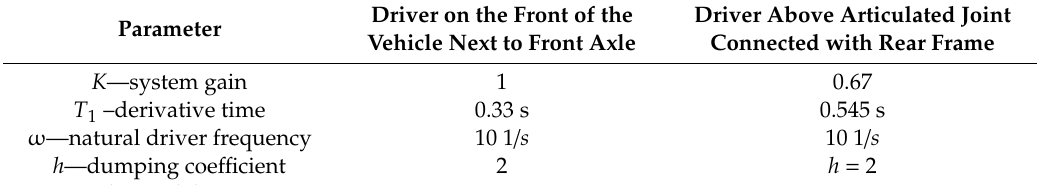
Table 3. Parameter of the Inert Driver Model.